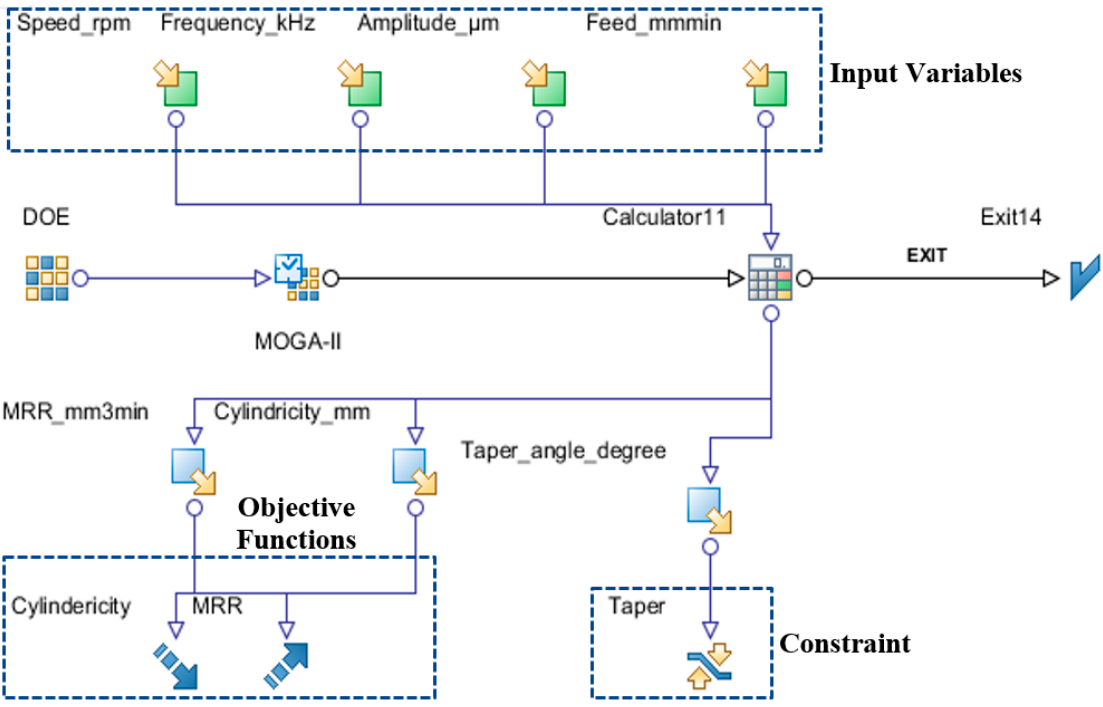
Figure 13. Optimization problem work flow